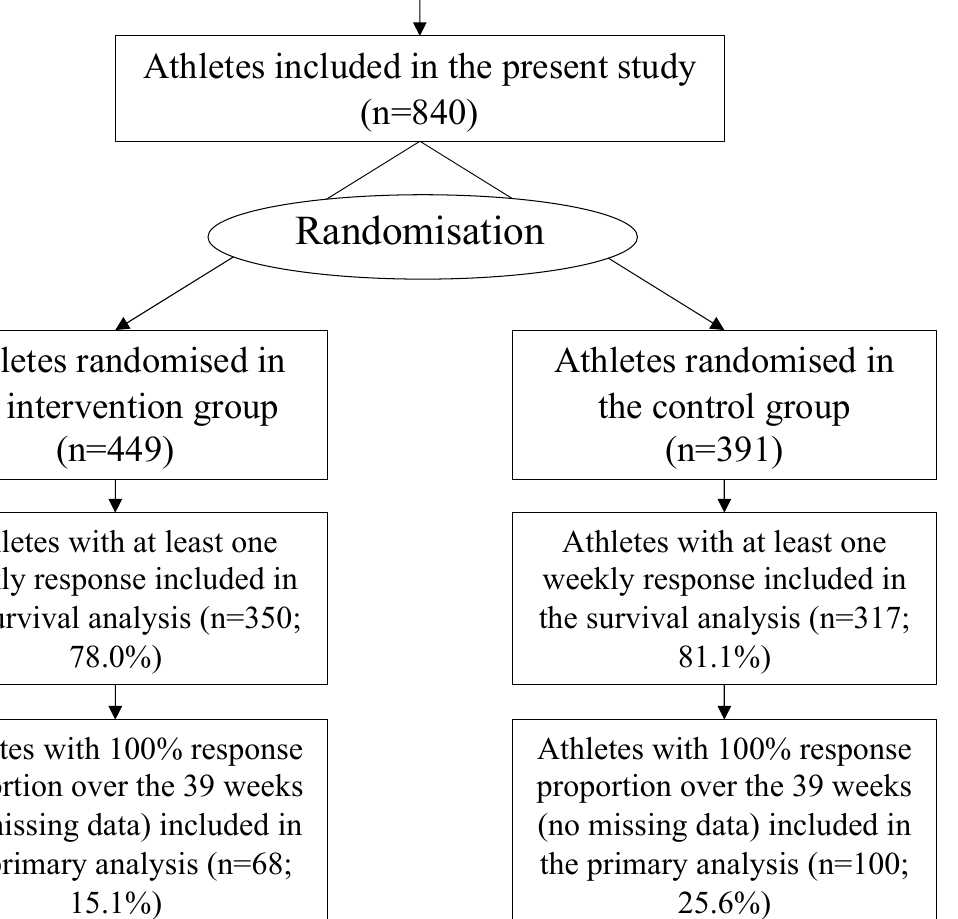
Figure 1. The CONSORT flow diagram of the